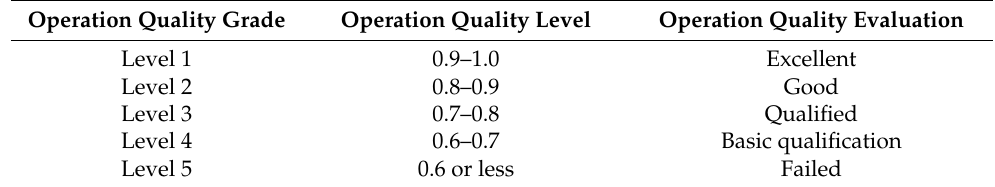
Table 1. Operation quality